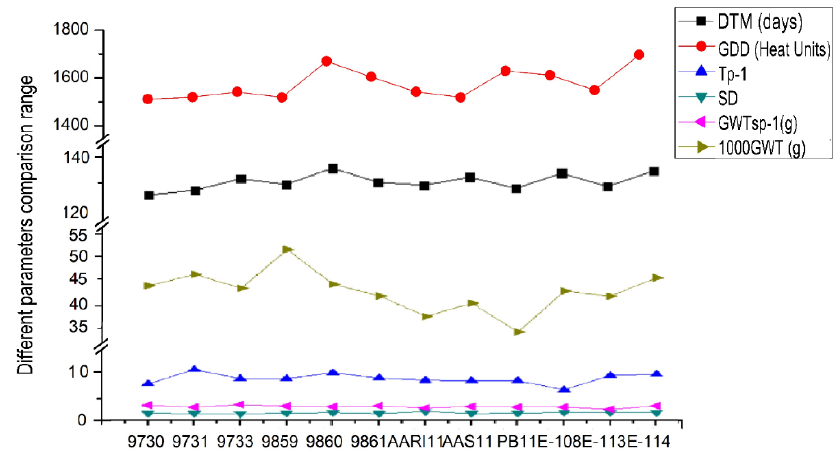
Figure 1. Mean performance for 12 parents (9 lines and 3 testers) compared at least significant difference (LSD) 0.05 . DTM, Days to 50% maturity; GDD, Growing degree days (heat unit); Tp − 1 , Productive tiller plant − 1 ; SD, Spike density; GWTsp − 1 , Grain weight spike − 1 (g); 1000 GWT, 1000 grain weight (g). Figure’s data can be found at Table